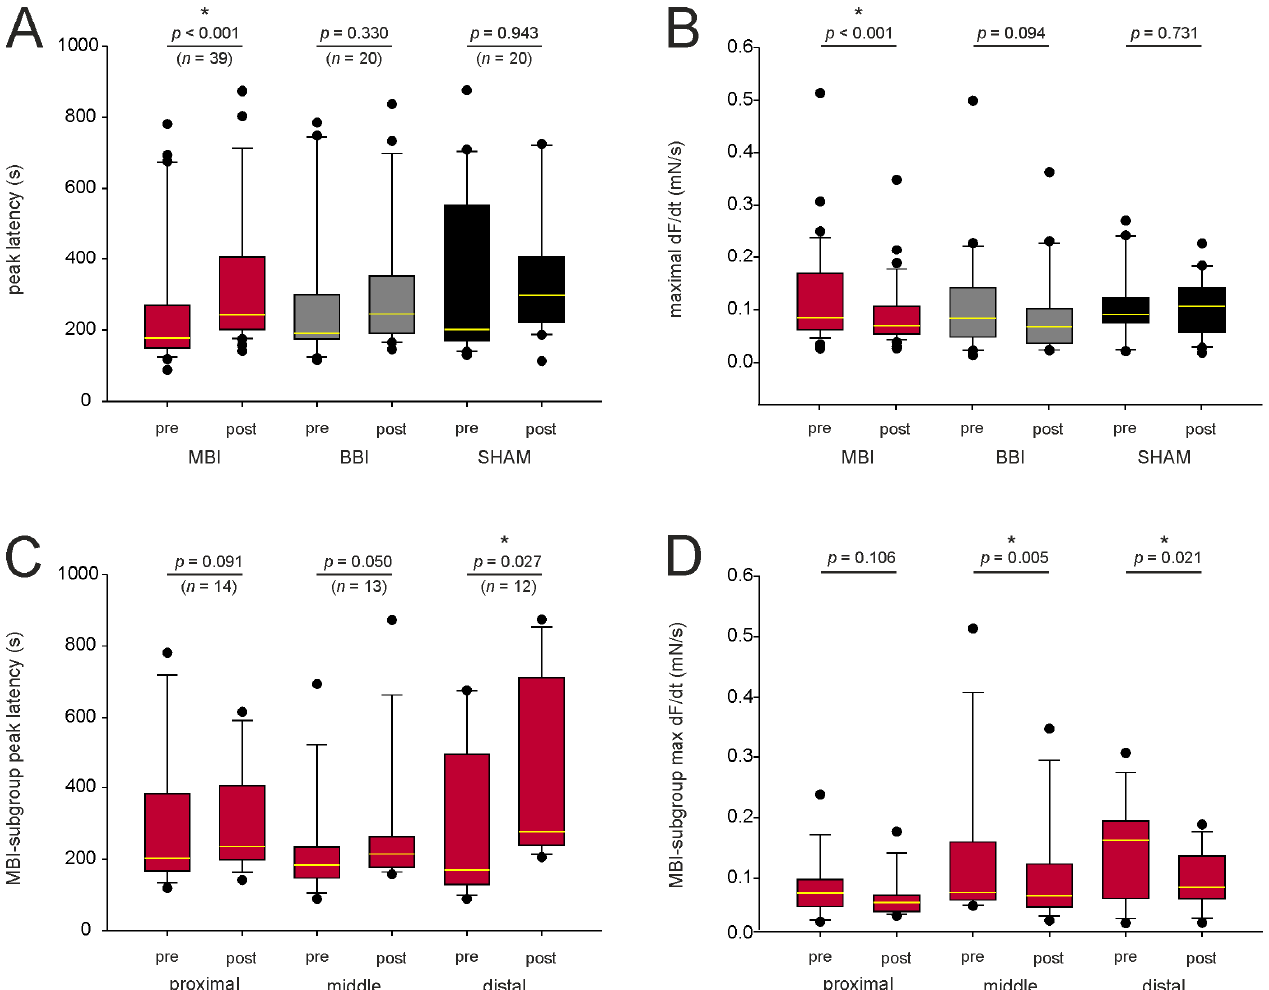
Figure 2. Characterization of the signal transduction. ( A , B ) CCH-induced contraction before and after irradiation for mean peak latency and mean force change. In the BBI and SHAM groups, there was no statistical difference (paired t -test resp. Wilcoxon test, p > 0.05), but mean peak latency significantly increased and mean maximal force change decreased after MBI. ( C , D ). In the subgroup analysis, only peak latency for the distal segment (Wilcoxon test, p = 0.027) and maximal force change for the middle (Wilcoxon test, p = 0.005) and distal (Wilcoxon test, p = 0.021) segment remained statistical different. P -values were calculated with a paired t -test, and, respectively, with a Wilcoxon test. Outliers are plotted as black dots. * p < 0.05; The median is illustrated by the yellow horizontal line. Abbreviations: MBI: microbeam irradiation (red boxplot); BBI: broadbeam irradiation (gray boxplot); SHAM: SHAM irradiation (black boxplot); pre-RT and post-RT: before (pre-) and after (post-) irradiation; CCH = carbachol. The number of segments is given in